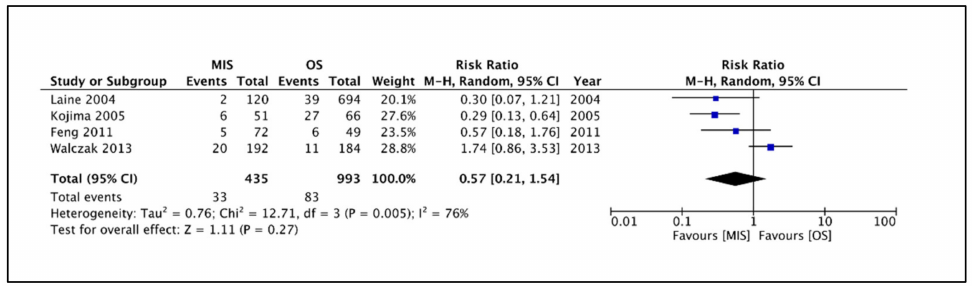
Figure 2. Forest plot comparison between the two patient groups in terms of the incidence of macroscopic glove perforations. Legends: MIS, minimally invasive surgery group. OS, open surgery group. M-H, Mantel–Haenszel method. CI, confidence